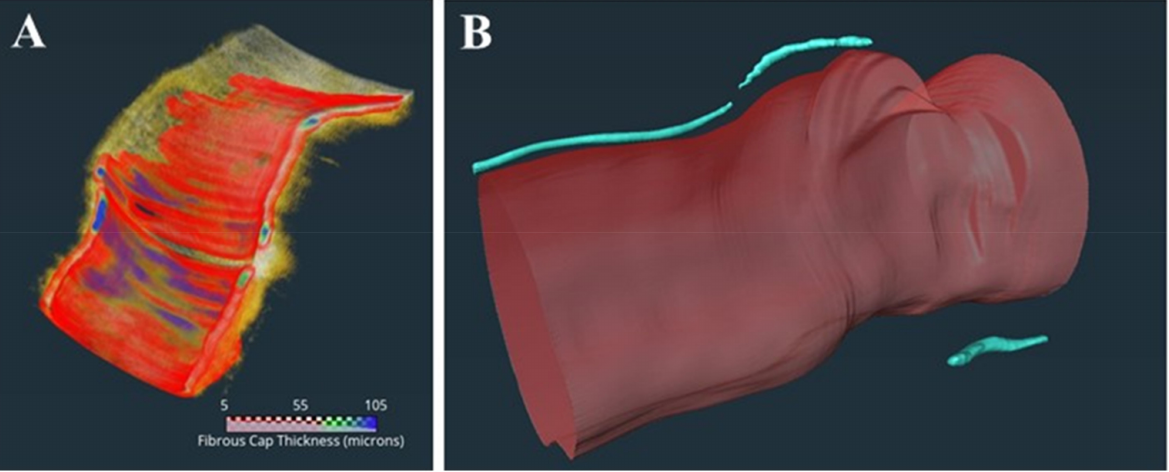
Figure 1. Three-dimensional (3D) visualization of IVOCT coronary-artery segments with ( A ) TCFA and ( B ) MC. A heatmap of fibrous-cap thickness is overlayed in ( A ), showing the TCFA region. As described in the text, TCFA (red) was defined as a plaque with a fibrous cap < 65 µ m and TCFA angle > 90 ◦ for each frame. The MC was detected as described in the text. In this instance, there were three microvessels (blue) in this plaque. The microvessels’ segments were 7.4 mm in length and their diameters were approximately 10.4 µ m. Multiple radiomic features captured the extent of TCFA and microvessel presence in plaques.